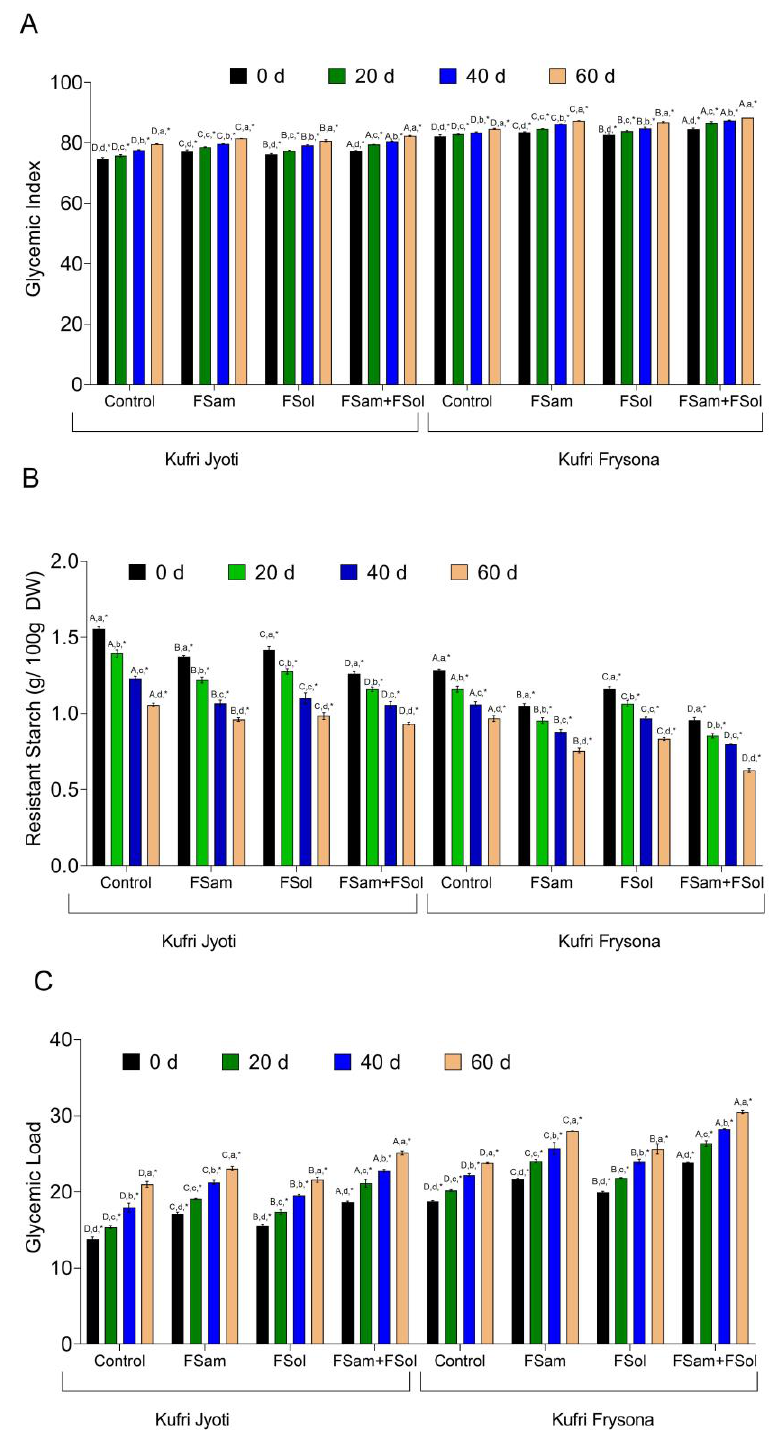
Figure 6. The effect of dry rot infection on ( A ) glycemic index, ( B ) resistant starch, and ( C ) glycemic load of cultivars Kufri Jyoti and Kufri Frysona; control, no pathogen infection; FSam, Fusarium sambucinum ; Fsol, Fusarium solani ; Fsam + Fsol, Fusarium sambucinum + Fusarium solani. Capital letter = significance of inoculum (within one date/cultivar combo); Lower case letter = significance of date (within one inoculum/cultivar combo); * = significance between cultivars (within one inoculum/date combo).